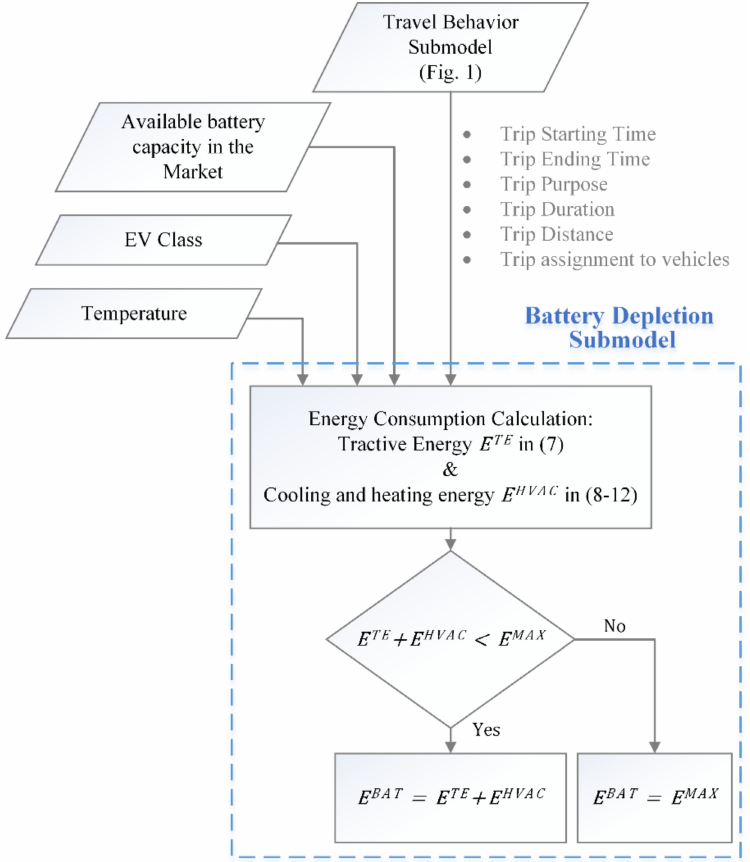
Figure 2. Battery depletion